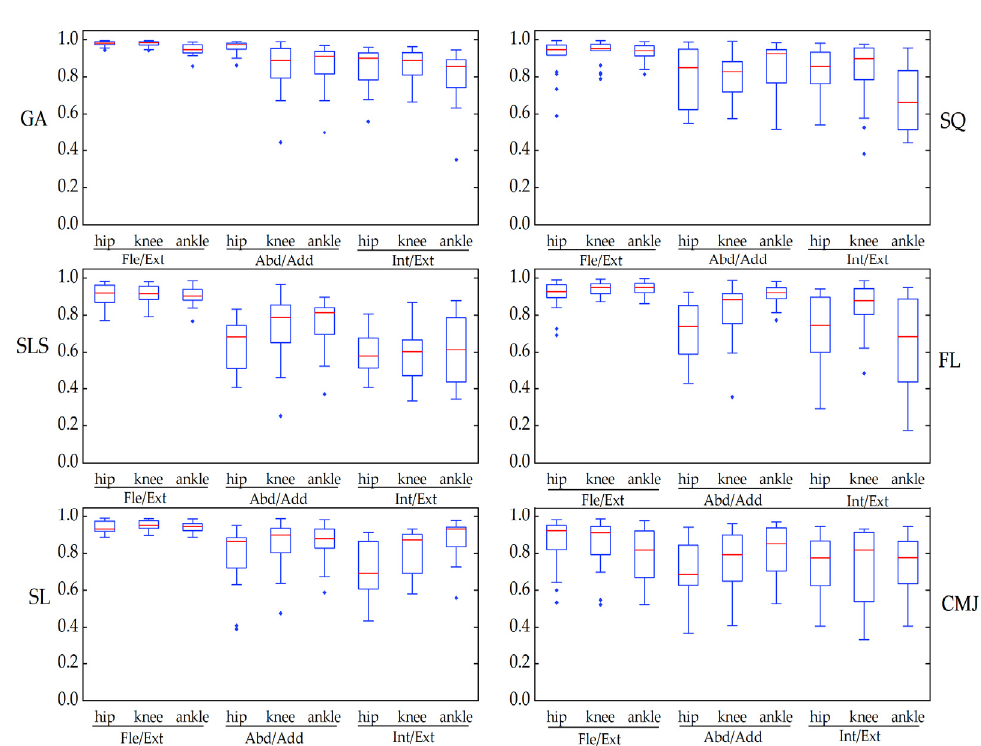
Figure A7. The waveform similarity in the OptiTrack system between two days was examined using box-and-whiskers plots of CMC values in the gait (GA), squat (SQ), single-leg squat (SLS), side lunge (SL), forward lunge (FL), and counter-movement jump (CMJ). Fle/Ext stands for “Flexion/Extension”, Abd/Add for “Abduction/Adduction”, and Int/Ext for “Internal/External Rotation”. Table A1. The intraclass correlation coefficient (ICC) of OptiTrack system. GA SQ SLS FL SL CMJ